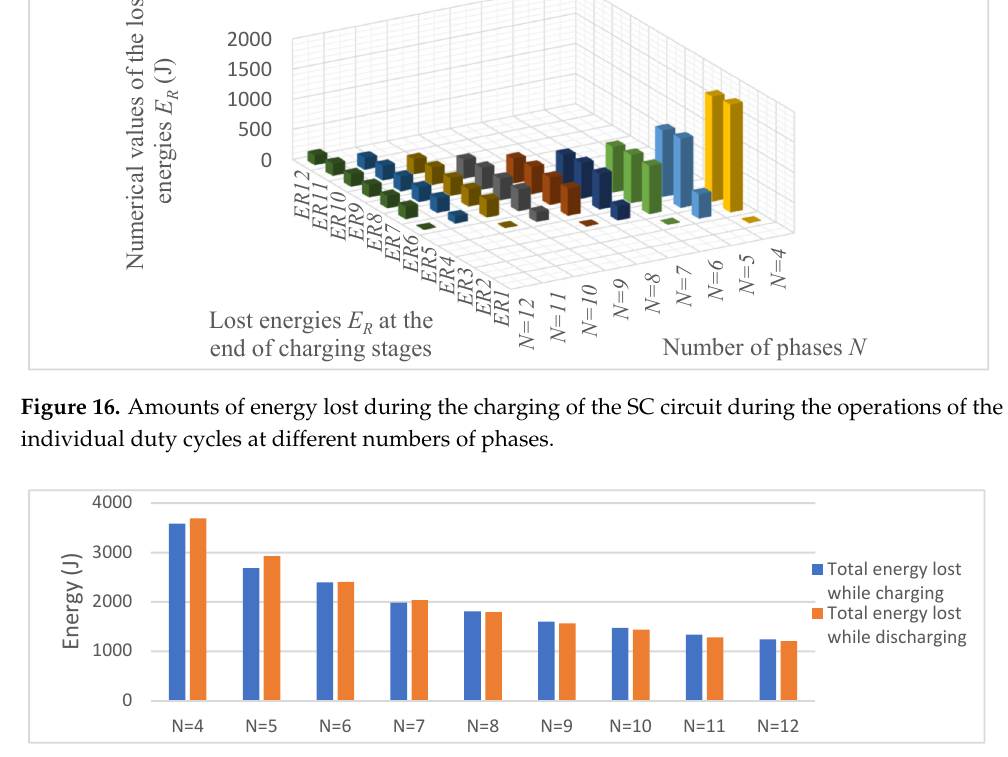
Figure 17. Comparative diagrams of total energies lost during charging and discharging of the SC circuit at different numbers of phases. The full energies transmitted to SC during the charging processes, the successfully stored energies (equal to the total discharged energies during the discharging processes), and the successfully discharged energies are shown in Figure 18 for each N . Figure 18. Comparative diagrams of total transmitted, stored, and successfully discharged energies of the SC circuit at different numbers of phases. Figure 19 shows the charging, discharging, and total charging/discharging efficien- cies calculated using Equations (14)–(16) for each number of phases N . A higher value of